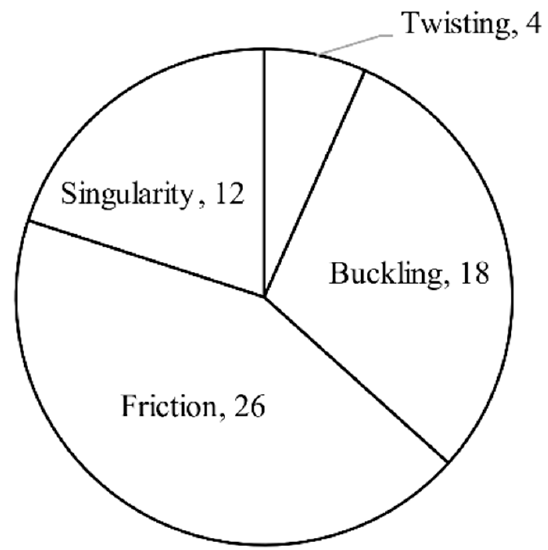
Figure 20. Numbers of publications about friction, buckling, singularity and twisting.